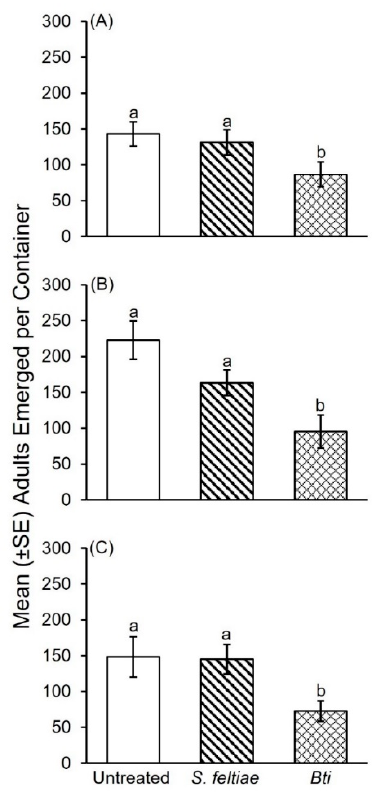
Figure 3. ( A – C ) Mean (± SE) number of adult fungus gnats that emerged from straw substrate inoc- ulated with P. columbinus and treated with either a water control, S. feltiae (Nemashield ® ), or B. thu- ringiensis var. israelensis (ABG-6193; Gnatrol ® ) during three independent bioassays. Three independ- ent bioassays were conducted over time and presented as A–C. Means within a bioassay with dif- ferent letters are significantly different (one-way ANOVA; Fisher’s LSD test; α =